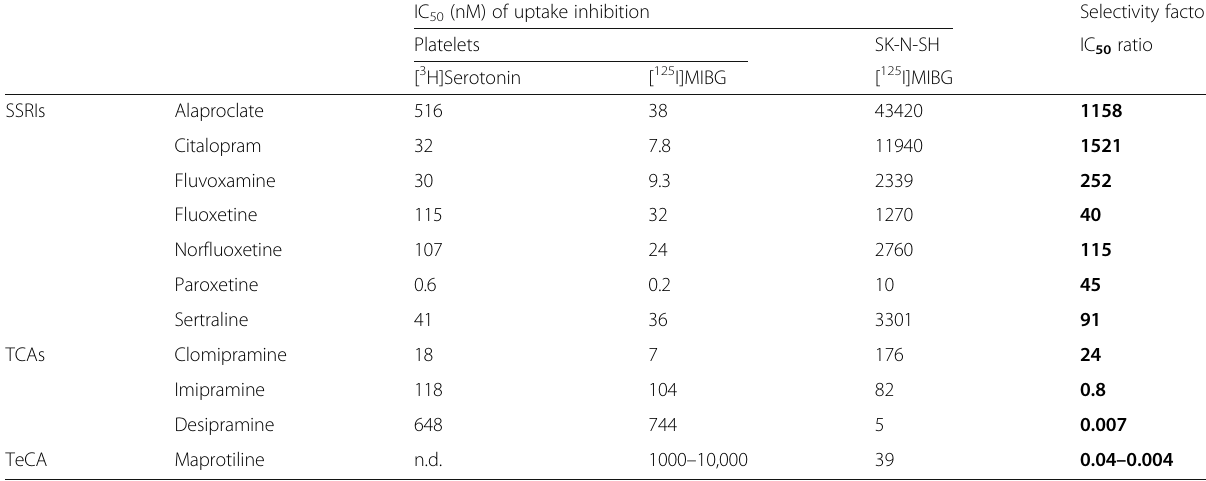
Table 1 The potency and selectivity of all tested monoamine transporter inhibitors IC 50 (nM) of uptake inhibition Selectivity factor